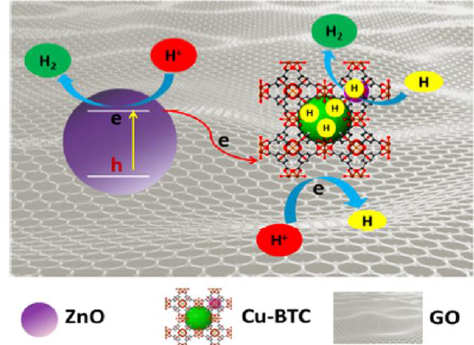
Figure 11. Schematic illustration of the electrostatic interaction assembly of ZnO/GO and Cu-BTC and its photocatalytic H 2 evolution mechanism. Reproduced with permission from Reference [74].